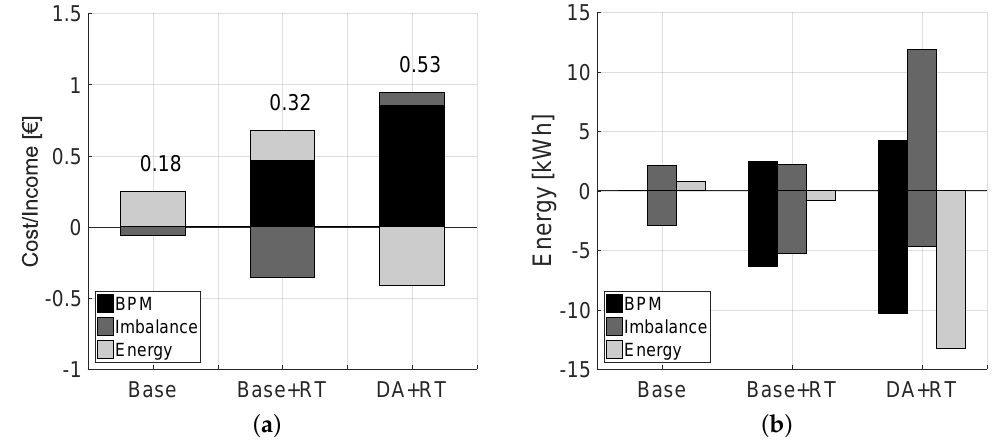
Figure 4. Daily values. ( a ) Stacked bar graph presenting the components of aggregator’s profit. Negative values are cost and positive income. The values above the bars are the daily profits; ( b ) Grouped bar graph presenting the amount of up/downregulation (up is negative value), positive/negative imbalance powers, and energy